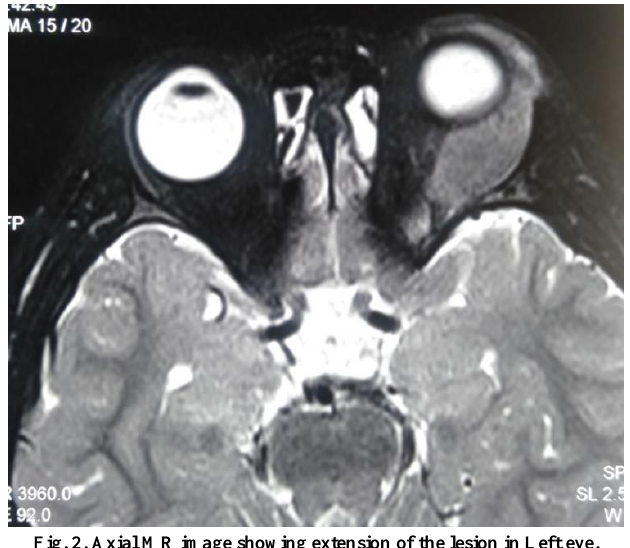
Fig. 4. Bone marrow analysis showing myeloblastic cells ( 100X magnification, H&E